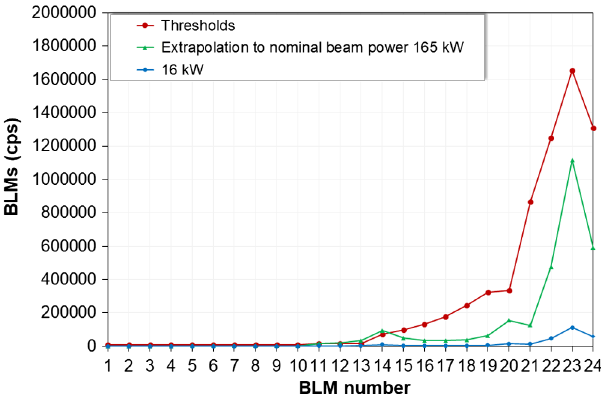
FIG. 19. BLMs count rate for the proton beam at 16 kW (blue), extrapolation to 100% duty cycle (green), and BLMs thresholds (red).